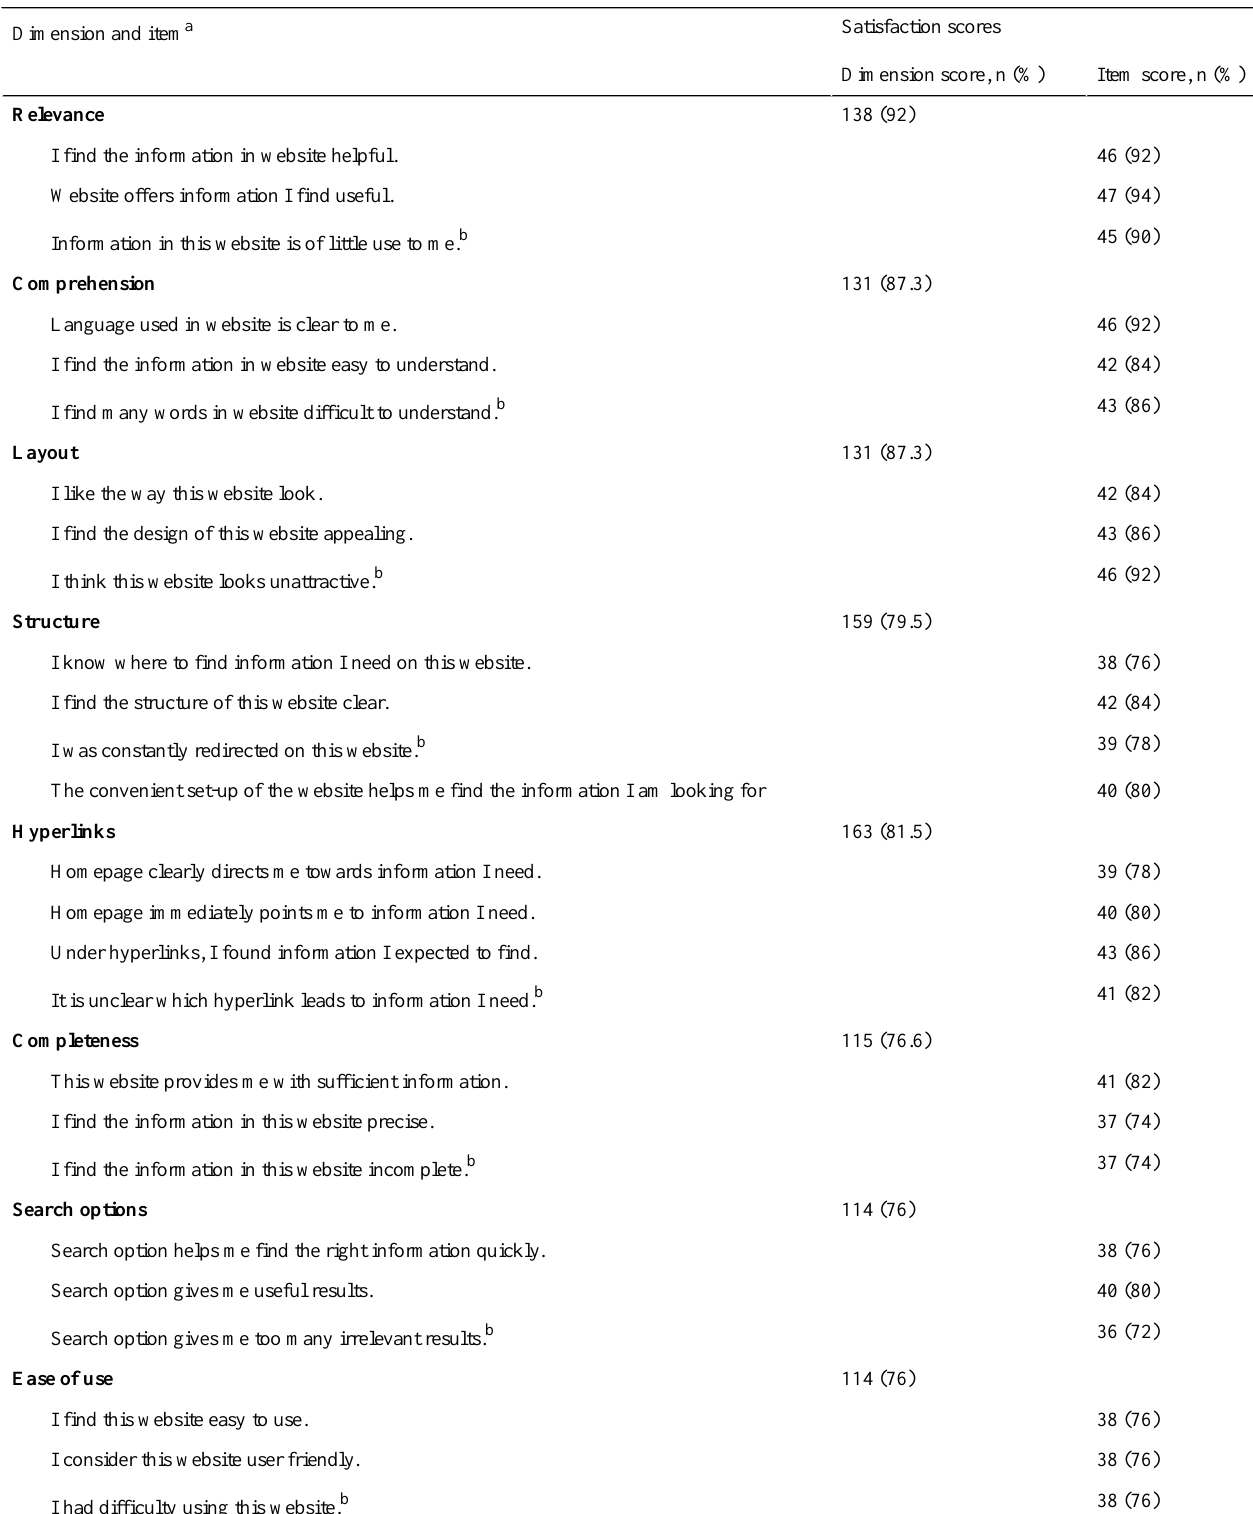
Table 2. Representative user satisfaction with the tool based on the Website Evaluation